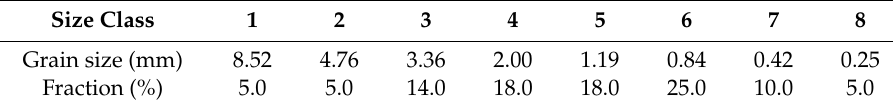
Table 2. Representative size classes of initial bed material.